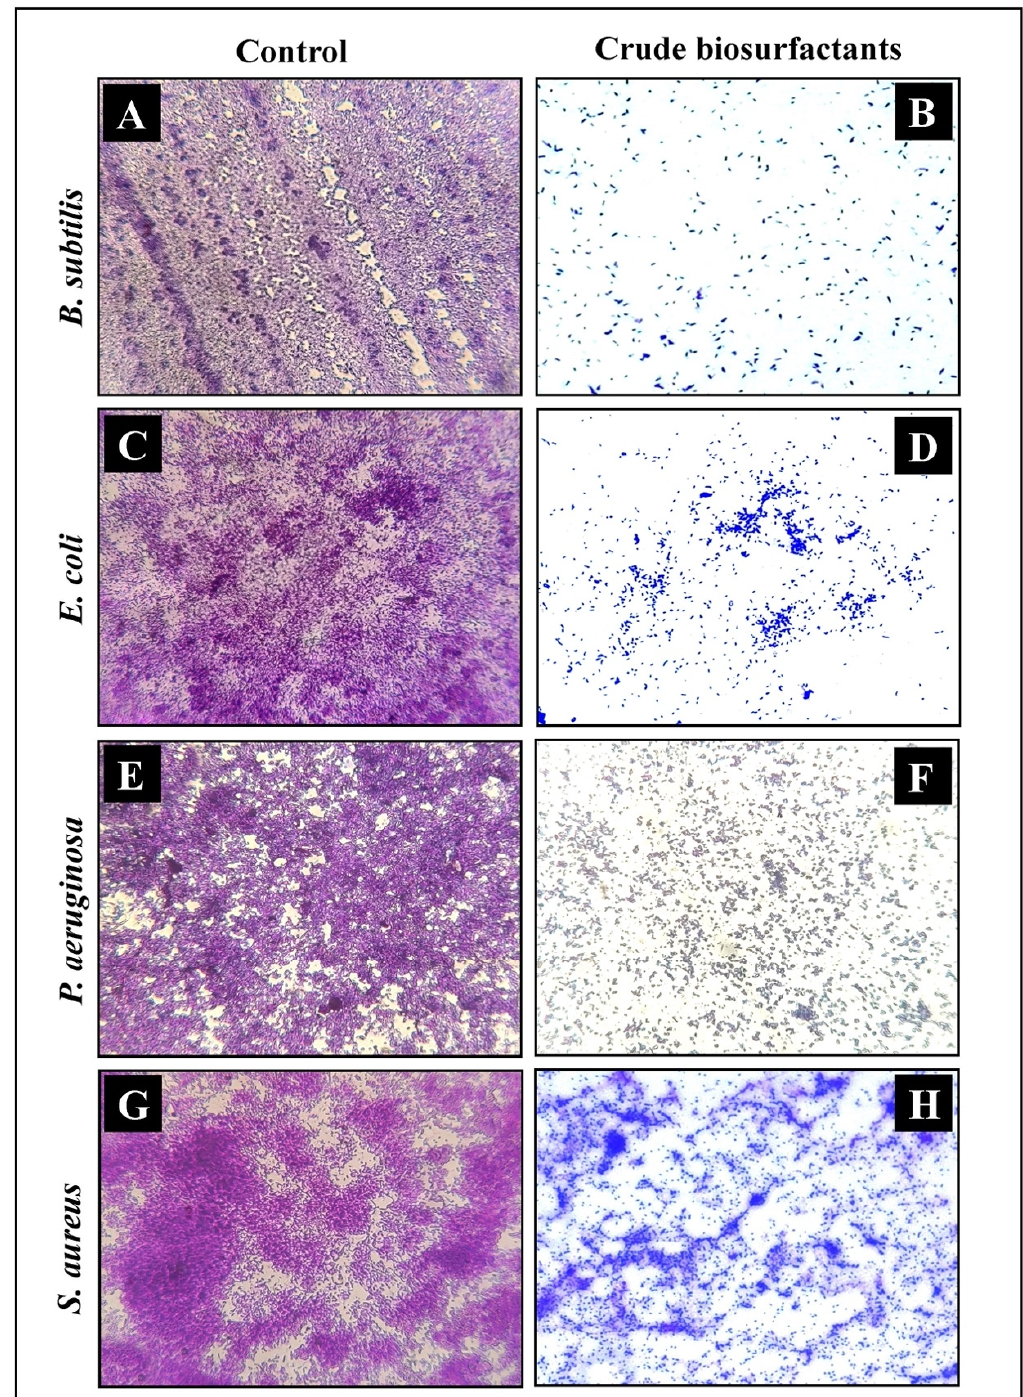
Figure 6. Micrographs of the disrupted matured biofilms of the test pathogens by the L. rhamnosus crude biosurfactant formed on a glass surface at their respective MICs under LM. Growth control ( A , C , E , G ); with the L. rhamnosus crude biosurfactant ( B , D , F , H ).